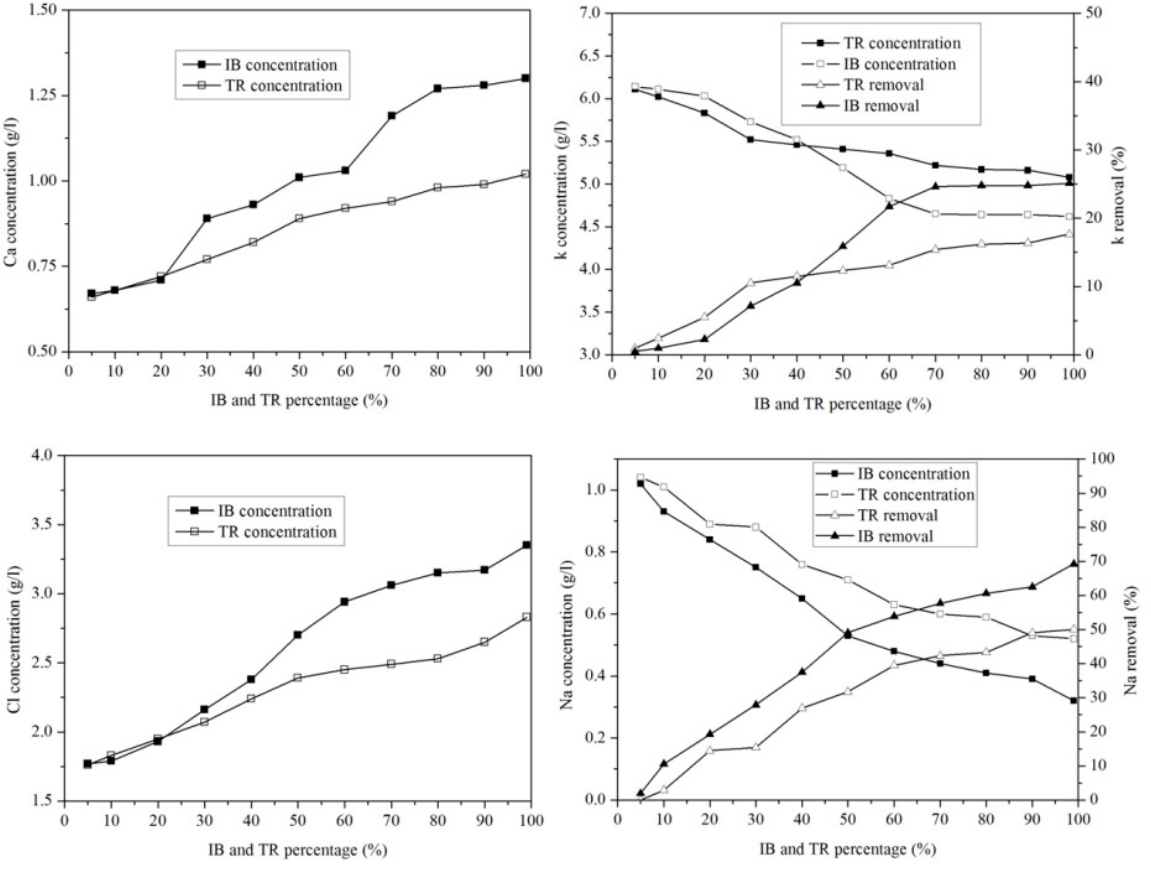
Figure 10. Concentration of and variation in micro-elements as a function of bentonite content.